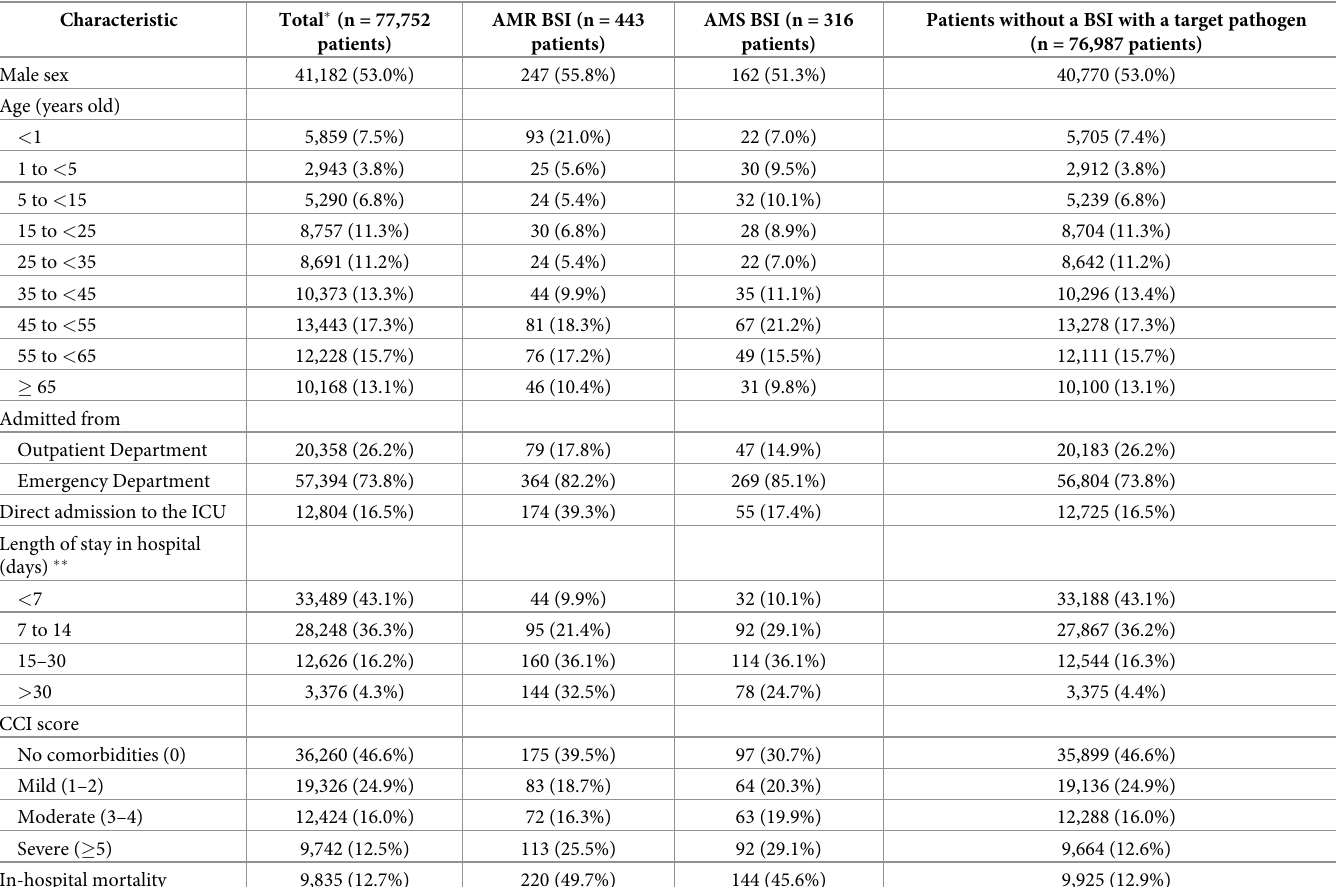
Table 1. Baseline